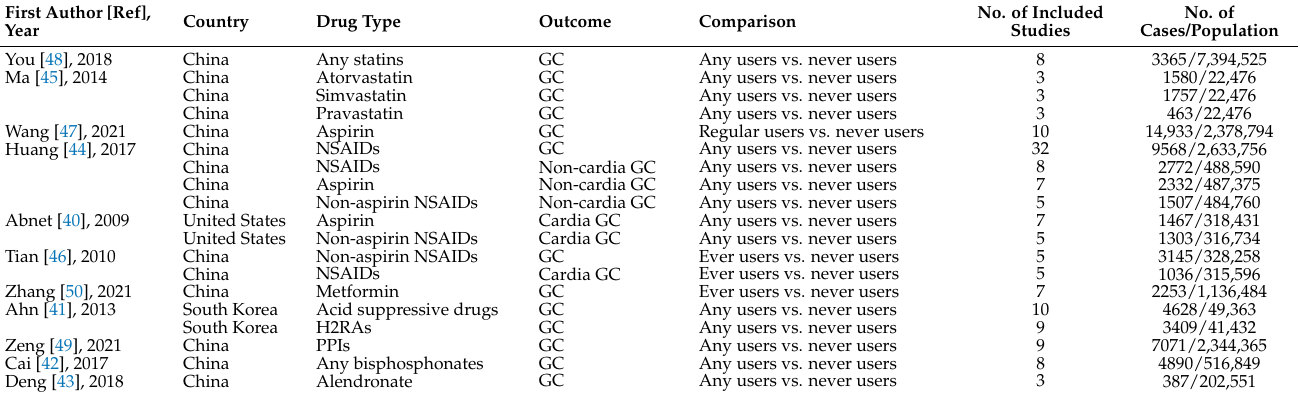
Table 1. Characteristics of the associations in the included systematic reviews and meta-analyses.